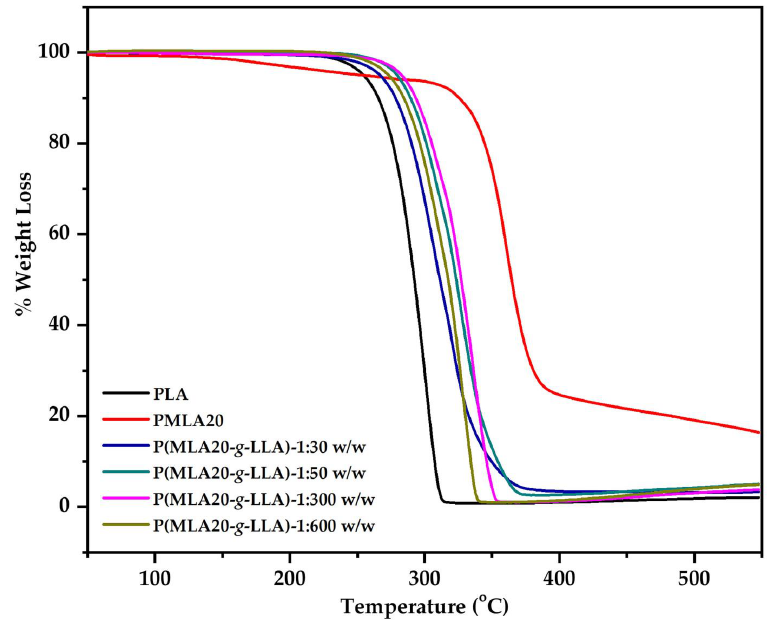
Figure 8. TG thermograms of PLA, PMLA 20 , and P(MLA20- g -LLA) with composition ratio of PMLA:LLA = 1:30, 1:50, 1:300, and 1:600 w / w